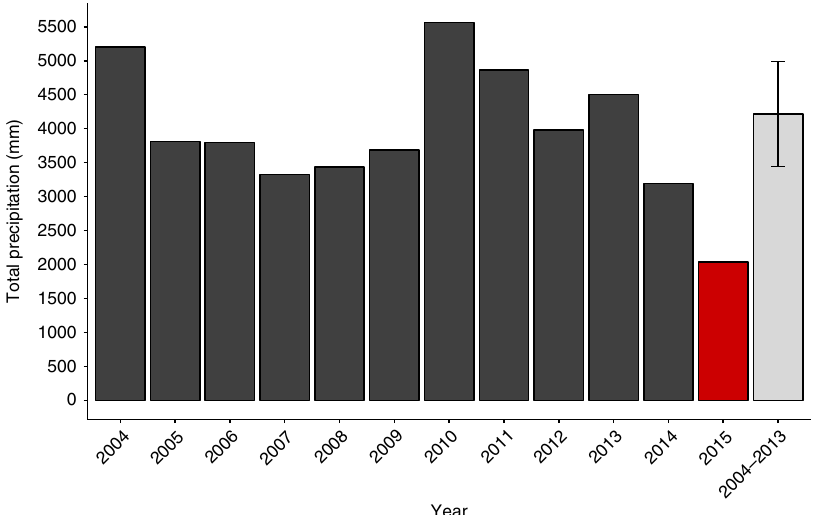
Fig. 1 Recent annual precipitation data for El Verde Research Station. Years 2004 – 2013 serve as recent comparison (mean and ±1 s.d. reported); this study includes observational data collected from 2014 to